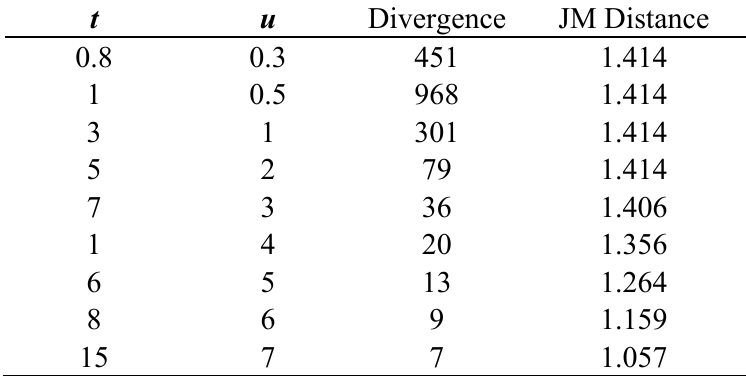
Table 1. Parameters used to construct simulated data and associated average class separability for change classes. See Equation (1) for definitions of t and u